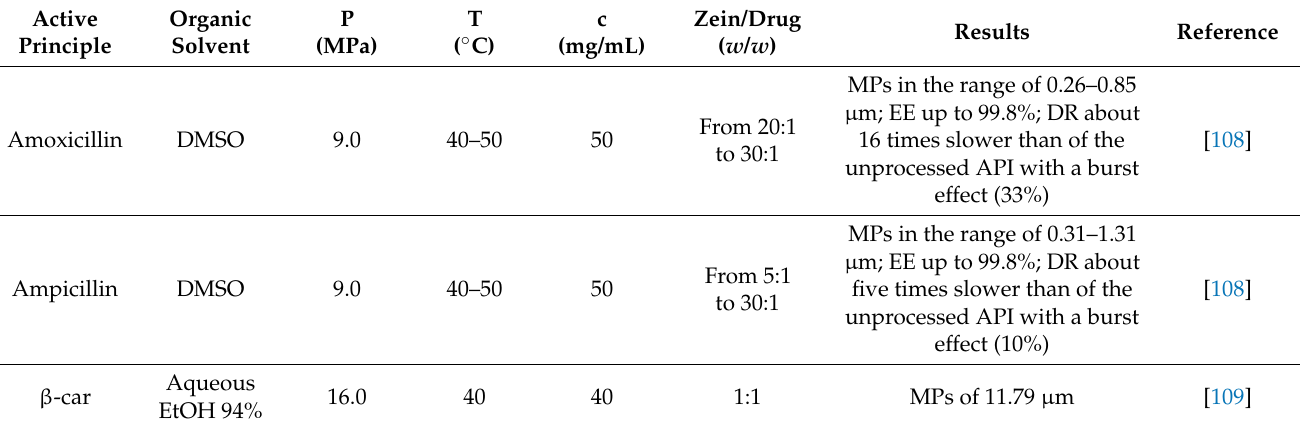
Table 2. Zein-based particles obtained using the SAS process. AC, acetone; β -car, β -carotene; c, con- centration in the liquid solution; δ -toc, δ -tocopherol; DCM, dichloromethane; DIC, diclofenac so-